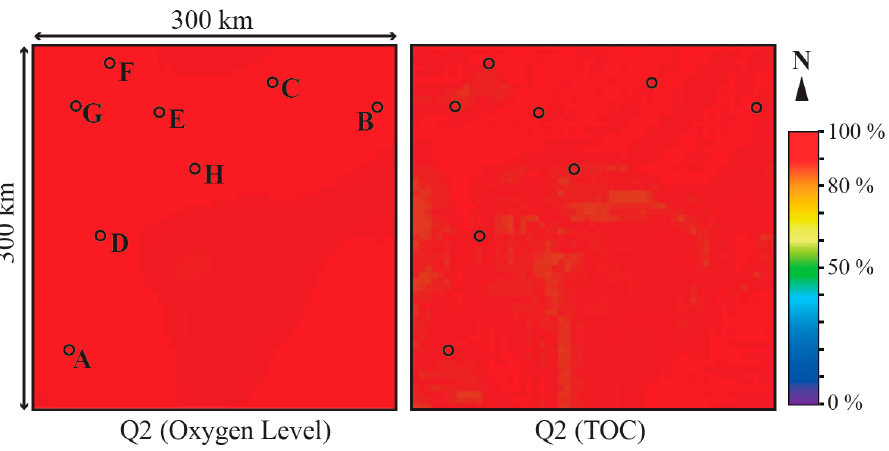
Figure 8. Quality indicator (Q2) maps for output parameters: Oxygen level and TOC.